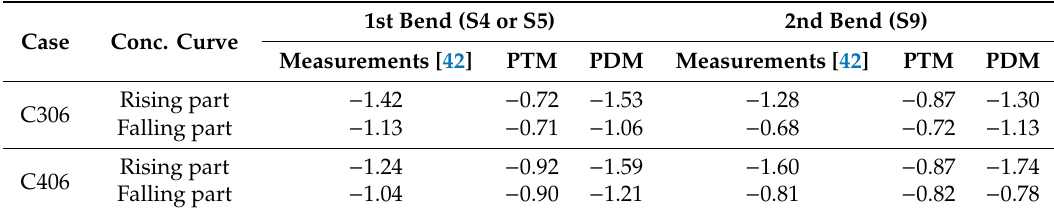
Table 2. Slope of the temporal variations of Chatwin’s parameters.